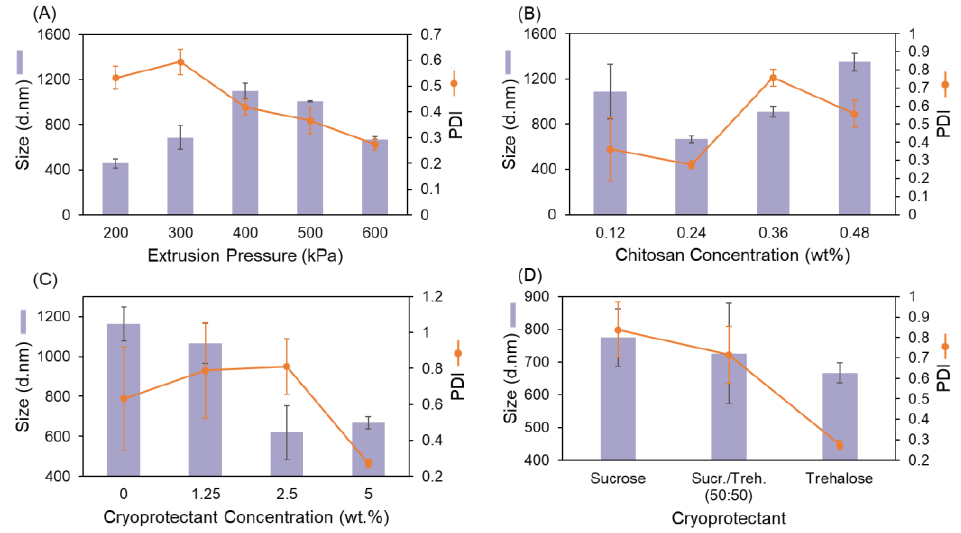
Figure 4. Effect of ( A ) extrusion pressure, ( B ) chitosan concentration, ( C ) trehalose concentration, and ( D ) type of lyoprotectant on product average diameter size and PDI. Data points represent mean ± SD ( n = 3).